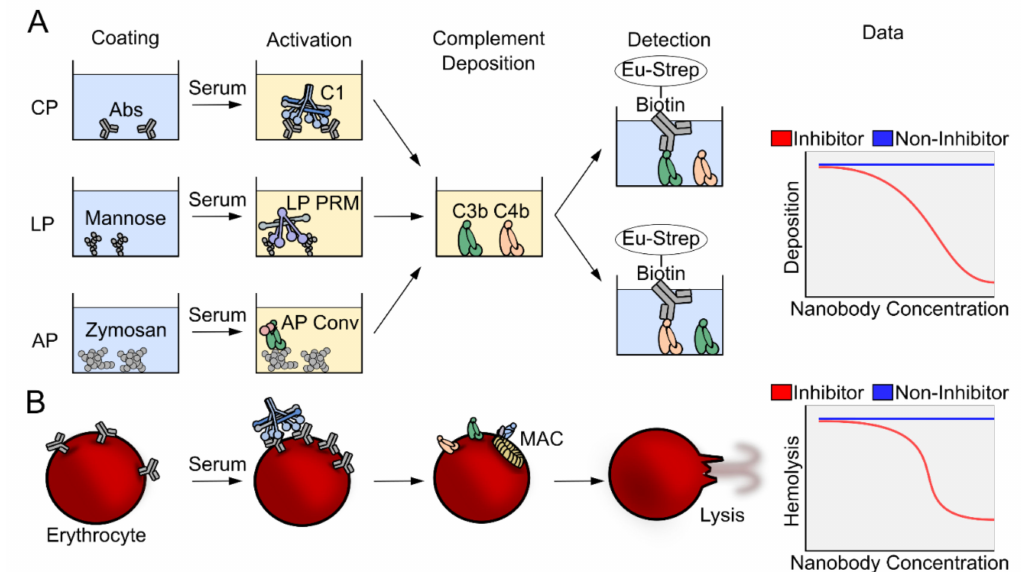
Figure 2. Overview of complement assays. ( A ) In ELISA based complement deposition assays, pathway-specific molecular patterns activate either the CP, the LP or the AP. The covalent binding of complement components allows thorough washing and subsequent readout of either C4 or C3 deposition. ( B ) CP activation can be provoked on sheep erythrocytes using specific antibodies. The complement system may progress to the terminal pathway and the assembly of the membrane attack complex that lyses the erythrocytes. The amount of hemoglobin released can be measured by spectrophotometry at 405 nm for quantification of the fraction of lysed